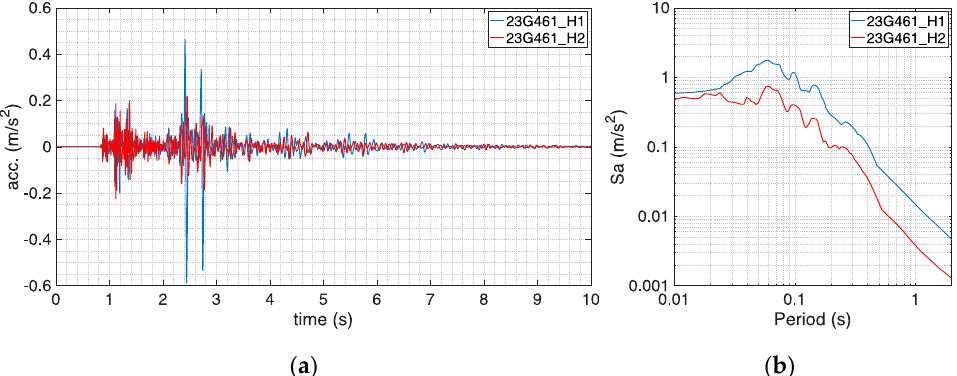
Figure 6. Horizontal components of record “Accel borehole” (already scaled by a factor of 3) in terms of acceleration ( a ) histories and ( b ) response spectra.